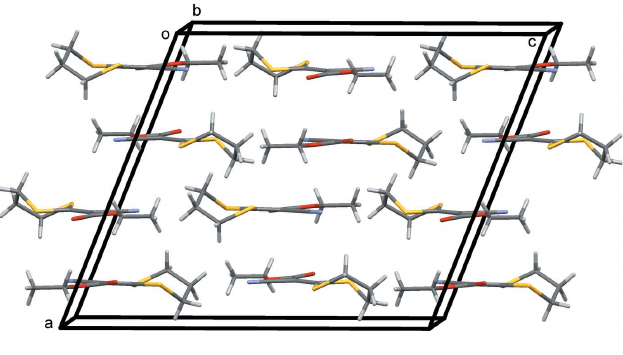
Figure 2 A view along the b axis of the crystal packing of the title compound (I).